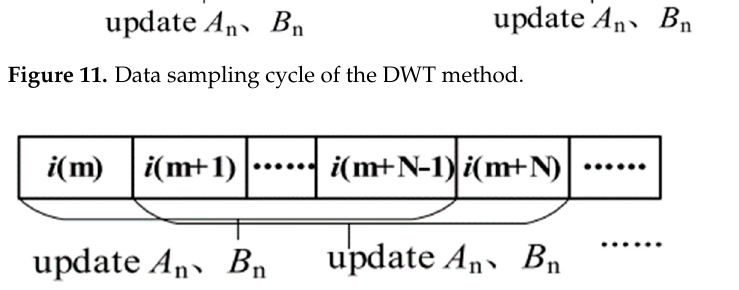
Figure 12. Data sampling cycle of the SDWT method.